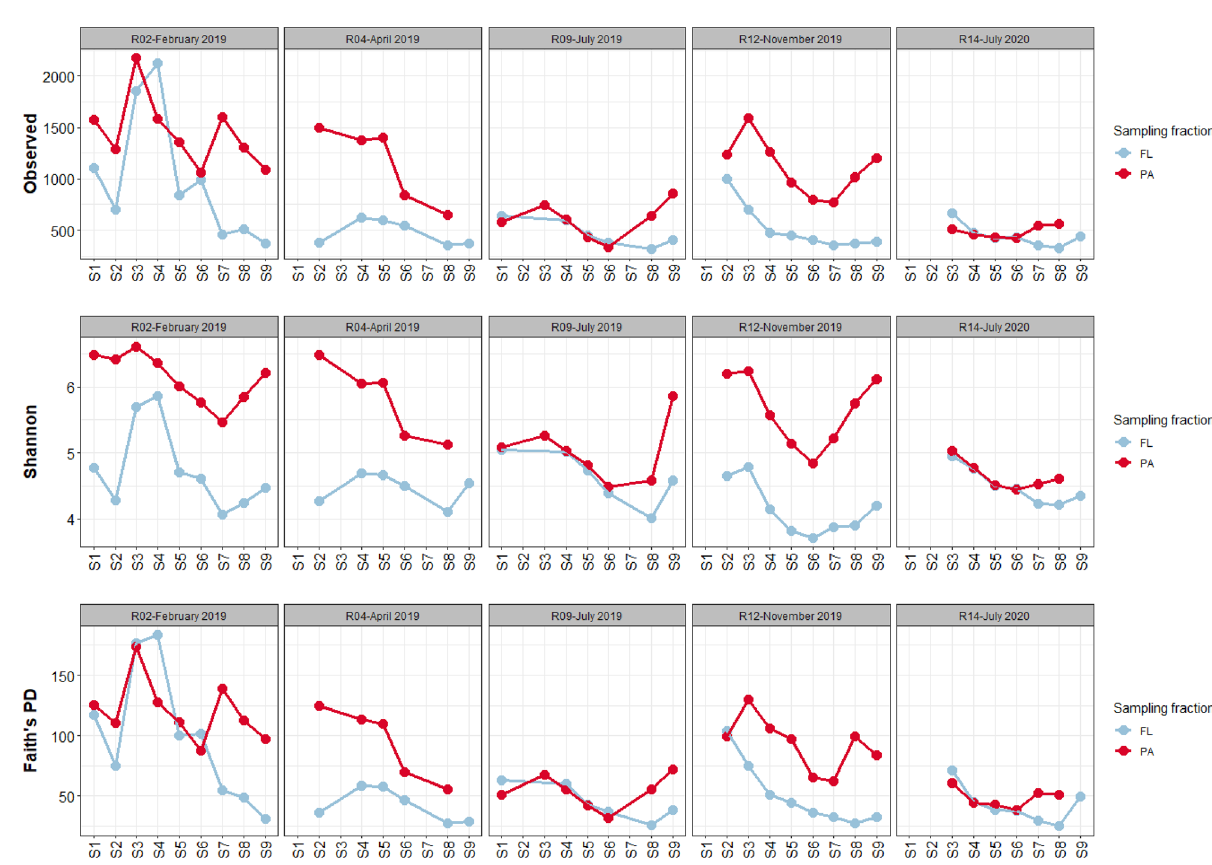
Figure 4. Alpha diversity indices (richness, Shannon index and Faith’s PD) characterizing the PA and FL communities along the Aulne estuary salinity gradient at the five sampling dates. Two samples were removed in the rarefication process (PA community in S9 of April 2019 and S9 of July